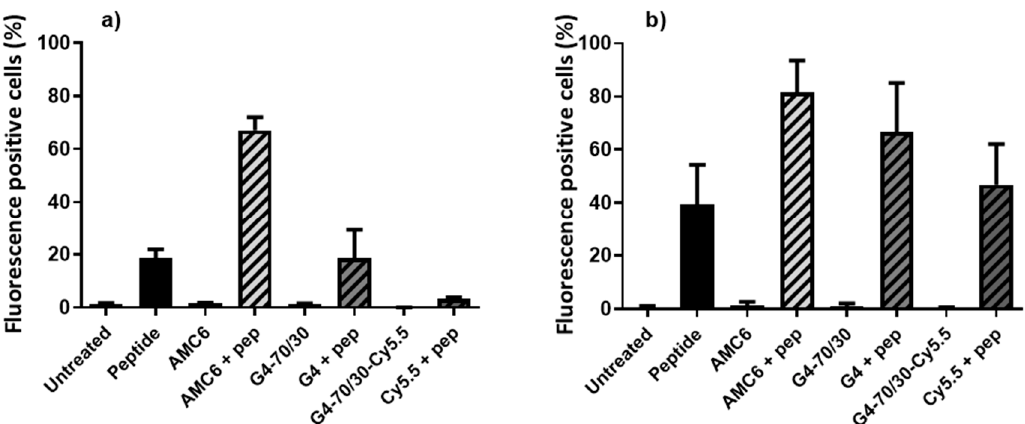
Figure 3. Entry of FITC labeled peptide into the DCs observed by flow cytometry. The nanoparticles, peptide and complexes were added to the DCs, and green fluorescence was quantified at ( a ) 2 h and ( b ) 24 h post-treatment. The percentage of FITC positive cells after acid wash significantly increased at 2 h when peptide was complexed with AMC6, and at 24 h when complexes are formed with both AMC6 and G4-70/30. The data show mean ± standard deviation of three independent experiments.